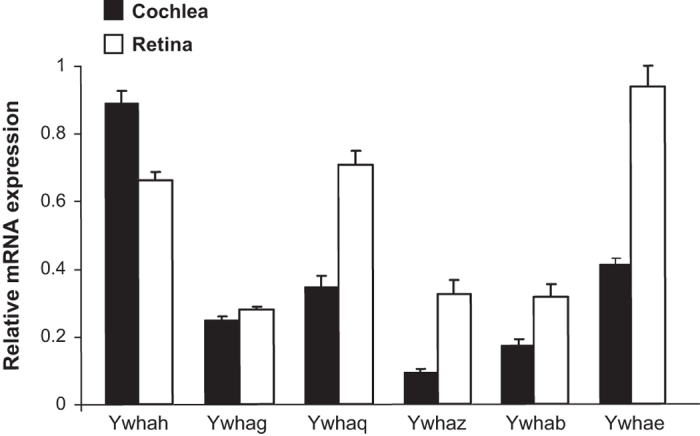
Expression of 14-3-3 transcripts in mouse retina and cochlea. Relative mRNA expression of 14-3-3 transcripts in mouse cochlea and retina were quantified by qPCR. Data are mean±S.E.M.